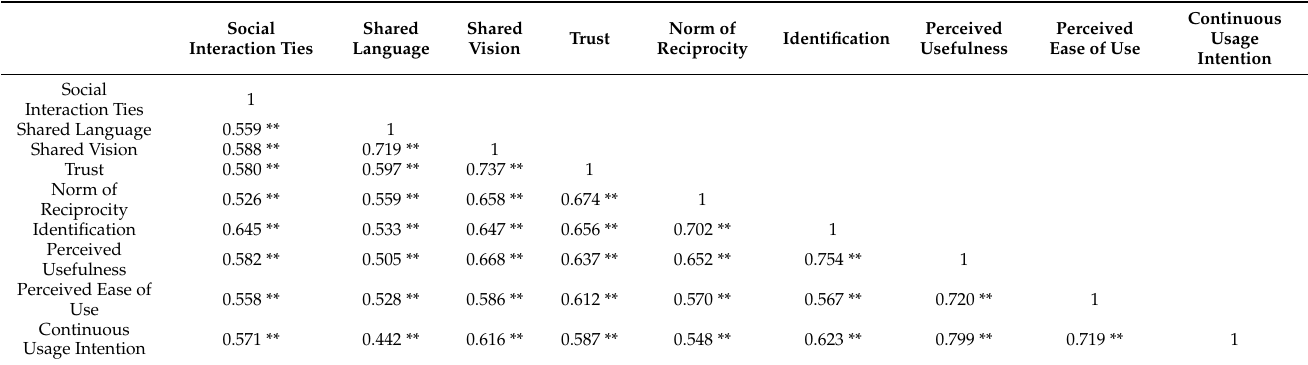
Table 7. Pearson correlation analysis.